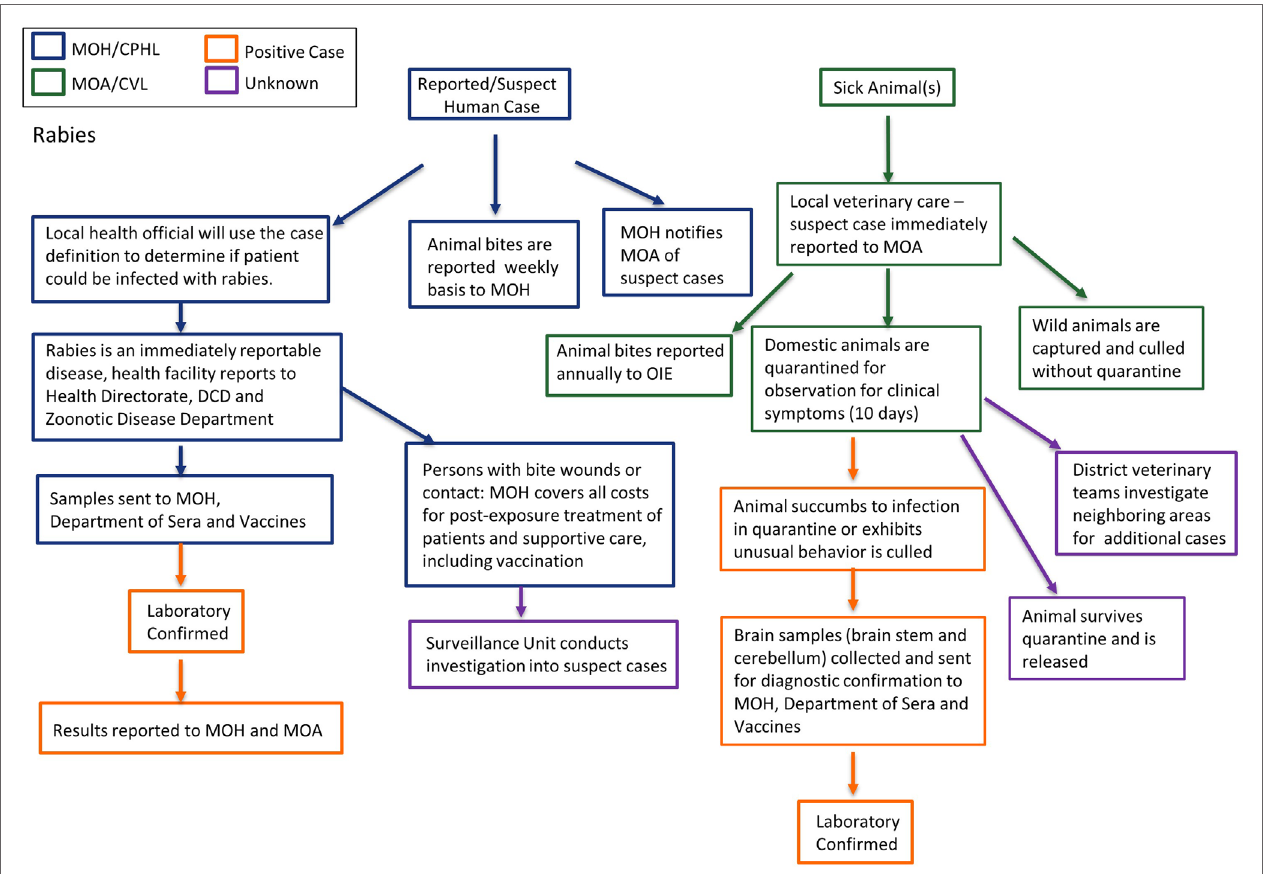
FigUre 4 | surveillance and laboratory mapping of rabies . Surveillance and laboratory networks for rabies, including nodes of communication and response, were mapped across human health and veterinary sectors. Systems were analyzed beginning from report of a suspect case to diagnostic confirmation, including evaluation: case reporting; reporting and sample submission; laboratory testing; case management; and outbreak investigation. Efforts in surveillance and response lead by Ministry of Health are represented in blue while those lead by Ministry of Agriculture are in green. Positive cases are noted in orange while unknown/ unconfirmed cases are represented in purple. Abbreviations: MOH, Ministry of Health; CPHL, Central Public Health Laboratory; DCD, Directorate of Communicable Diseases; MOA, Ministry of Agriculture; CVL, Central Veterinary